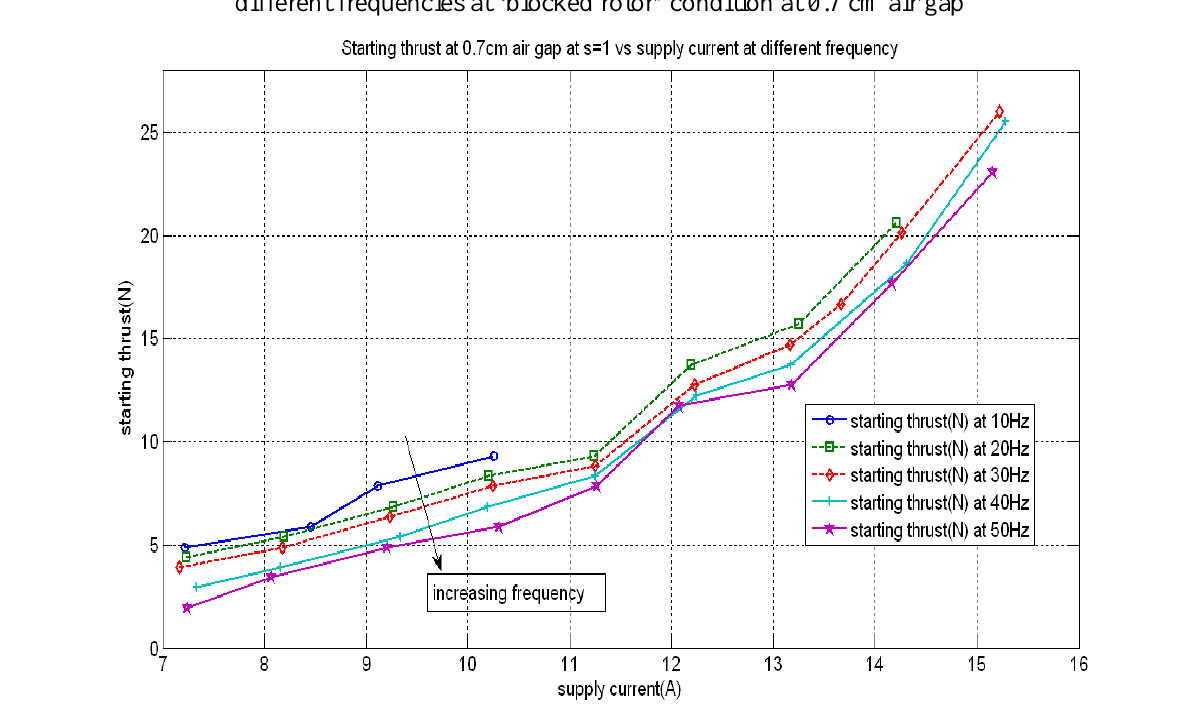
different frequencies at ‘blocked rotor’ condition at 0.7 cm air